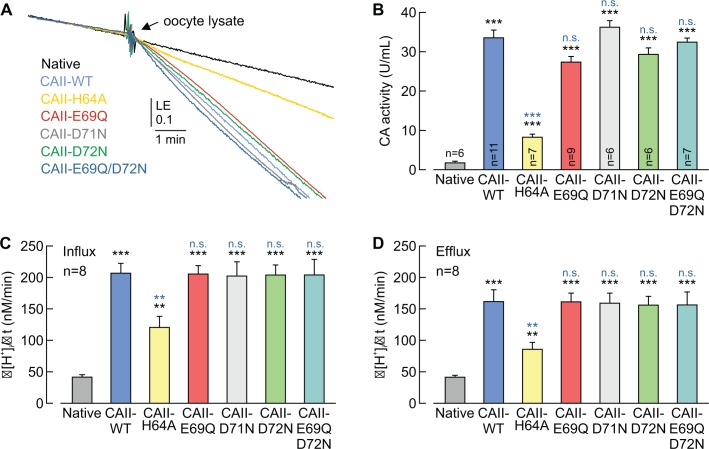
CAII-Glu69 and Asp72 do not support CAII catalytic activity.(A) Original recording of the log enrichment (LE) of either a lysate of 20 native oocytes (black trace) or a lysate of 20 oocytes expressing CAII-WT (blue), CAII-H64A (yellow), CAII-E69Q (red), CAII-D71N (gray), CAII-D72N (green), or the double mutant CAII-E69Q/D72N (turquoise). The beginning of the traces shows the rate of degradation of the 18O-labelled substrate in the non-catalyzed reaction; the black arrow indicates the addition of oocyte lysate. (B) Enzymatic activity of CA in units/ml (mean +SEM). The black asterisks refer to the values from native oocytes, the blue significance indicators refer to the values of oocytes expressing CAII-WT. (C, D) Rate of change in intracellular H+ concentration (Δ[H+]/Δt) as induced by the application (C) and removal (D) of 5% CO2/10 mM HCO3– to/from native oocytes and oocytes expressing CAII-WT, CAII-H64A, CAII-E69Q, CAII-D71N, CAII-D72N or the double mutant CAII-E69Q/D72N (mean +SEM). **p≤0.01, ***p≤0.001, n.s. no significance; Student’s t-test.10.7554/eLife.35176.022Figure 7—source data 1.Original dataset for Figure 7.